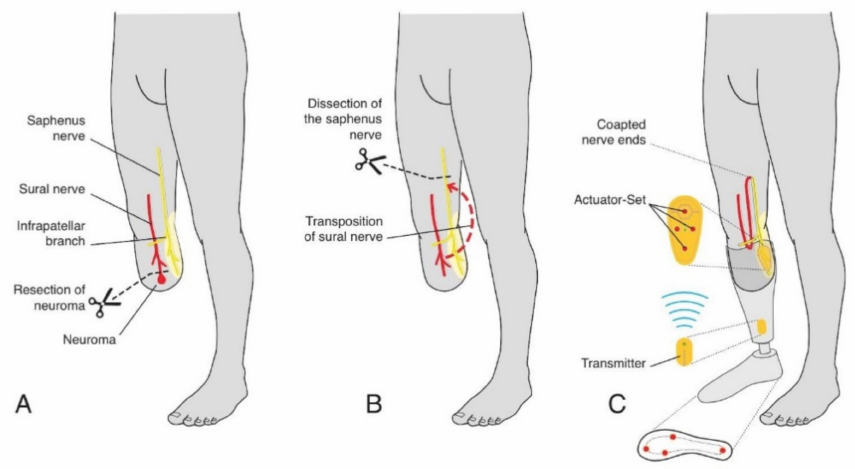
Figure 2. Illustration of the surgical technique for a transtibial amputation: ( A ) resection of the stump neuroma; ( B ) transposition of the ipsilateral sural nerve to the cutaneous territory of the saphenous nerve; ( C ) medical device Suralis in place, providing sensory feedback from the sole to the reinnervated skin area.